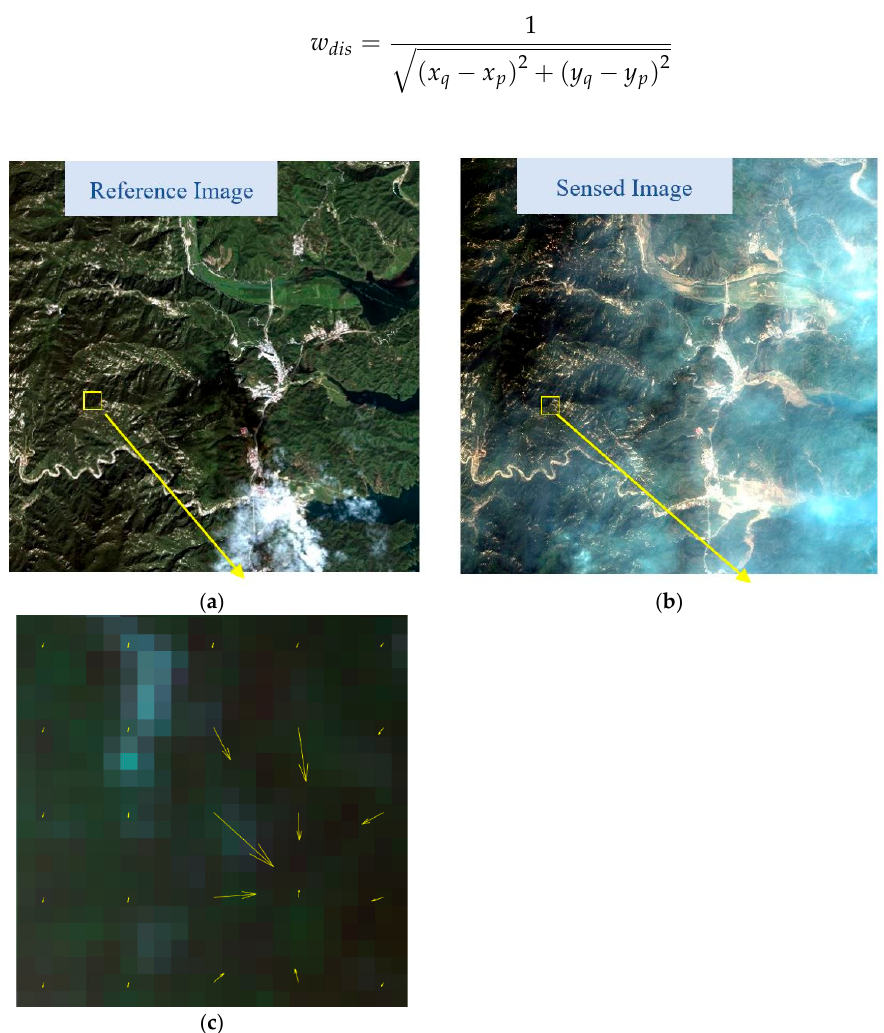
Figure 3. Displacement field of the local region. ( a ) Reference image, ( b ) sensed image, ( c ) the displacement field of corresponding pixels in the yellow rectangle.